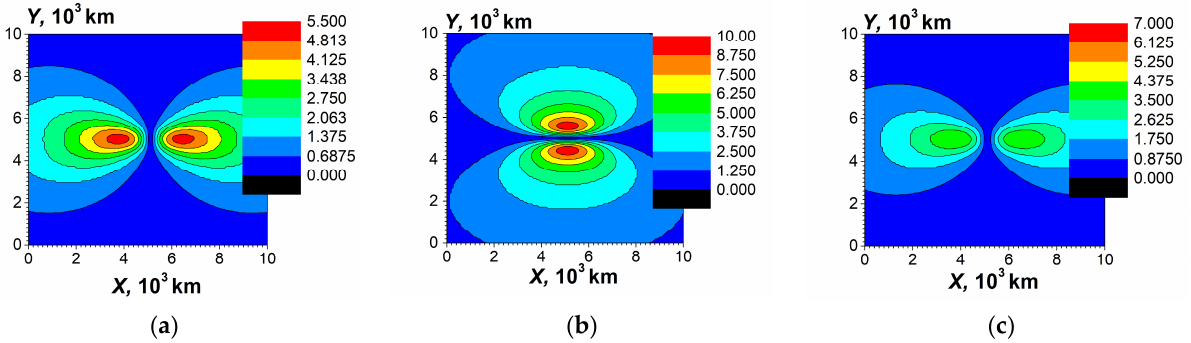
Figure 11. Distributions of the electric field components (in mV/m) in the ionosphere F -layer at the height z = 200 km. The quasi-electrostatic simulations, the case of closed geomagnetic field lines. The frequency is ω = 0.025 s − 1 . It is increased inclination angle compared with Figure 8. Part ( a ) is |E x (x,y)| , ( b ) is |E y (x,y)| , ( c ) is |E z (x,y)| . The geomagnetic field inclination is θ i = 40°. The part of the higher ionosphere and the magnetosphere above 300 km has been eliminated by means of the short circuit along the geomagnetic field lines.